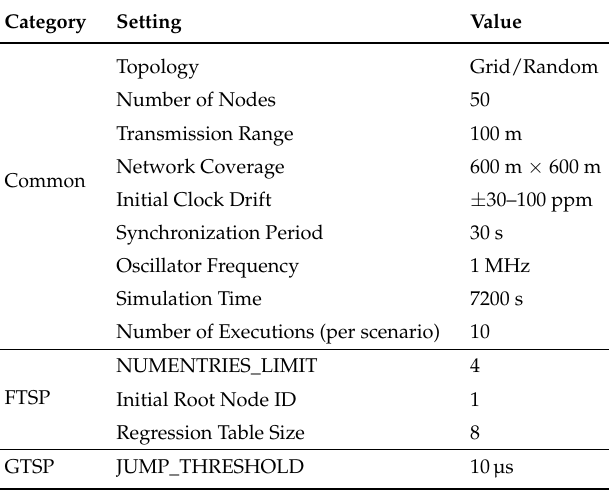
Table 1. Setting values in